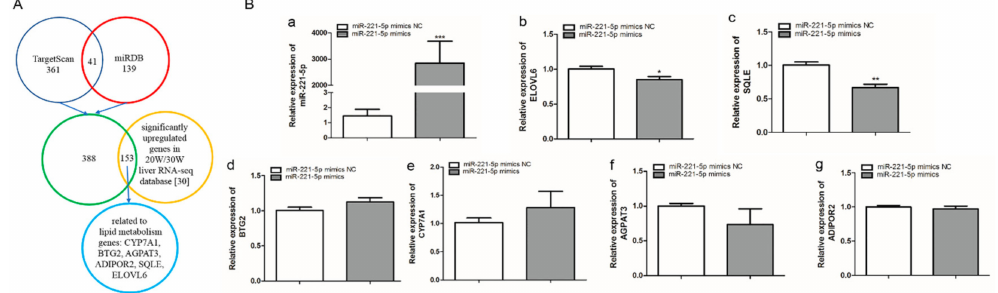
Figure 3. Screening of gga-miR-221-5p candidate target genes. ( A ) The selection process of the gga-miR-221-5p target genes. ( B ) Relative expression levels of gga-miR-221-5p and candidate target genes after gga-miR-221-5p mimics treatment for 48 h. * means 0.01 < p < 0.05, ** means 0.001 < p < 0.01, *** means p < 0.0001.